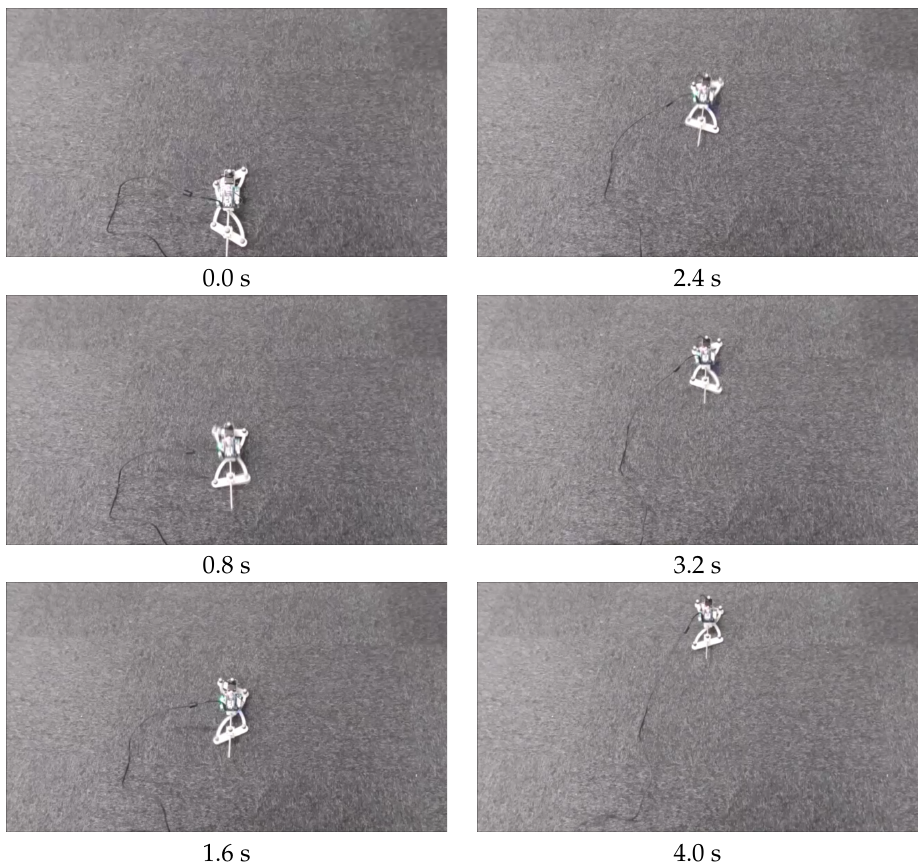
Figure 21. Snapshots of the forward locomotion